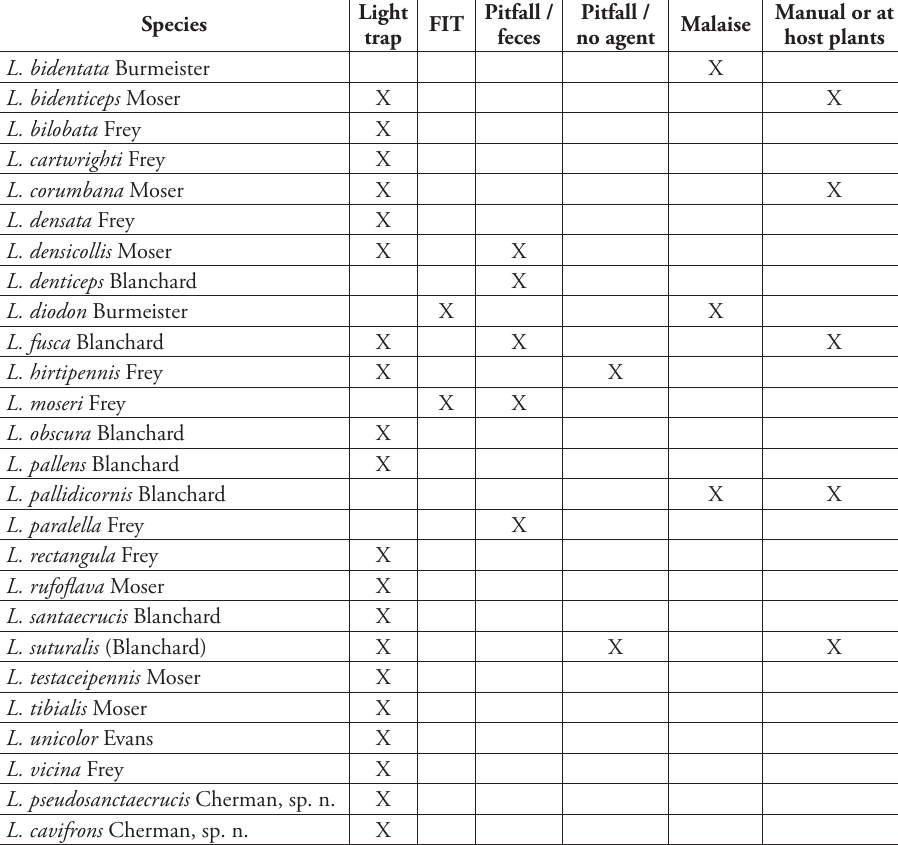
Table 2. Species with labeled data about sampling method (type of trap/manual).